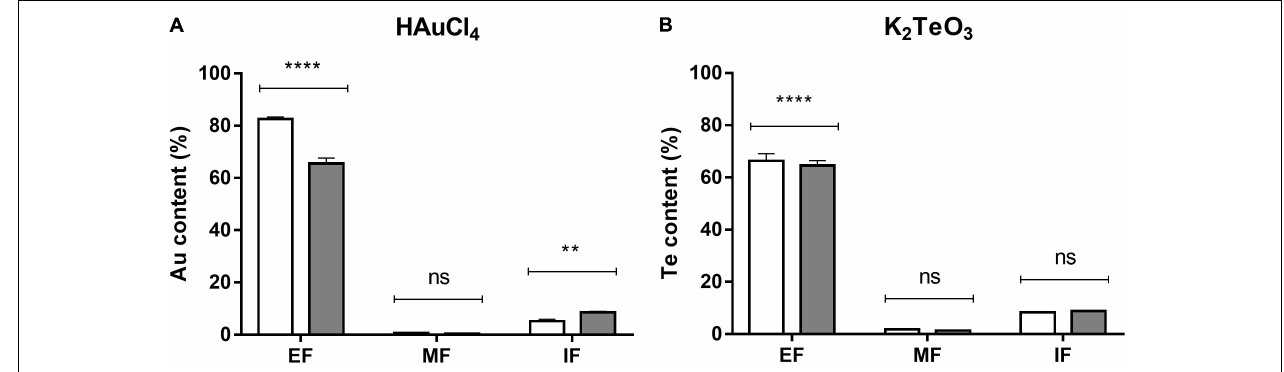
FIGURE 3 | Au and Te content in E. cloacae MF01 exposed to the indicated toxicants under aerobic and anaerobic growth conditions. Au and Te content was determined in the extracellular (EF), membrane (MF) and intracellular fractions (IF) of bacteria exposed to HAuCl 4 (A) or K 2 TeO 3 (B) for 15 min in aerobic (white bars) or anaerobic (gray bars) conditions. Toxic concentrations were as indicated in the legend to Figure 2 . Au and Te content are expressed as % of the initial treatment concentration. Bars represent the average of three independent tests ± SD. ∗∗ p < 0.0029; ∗∗∗∗ p < 0.0001; ns, not